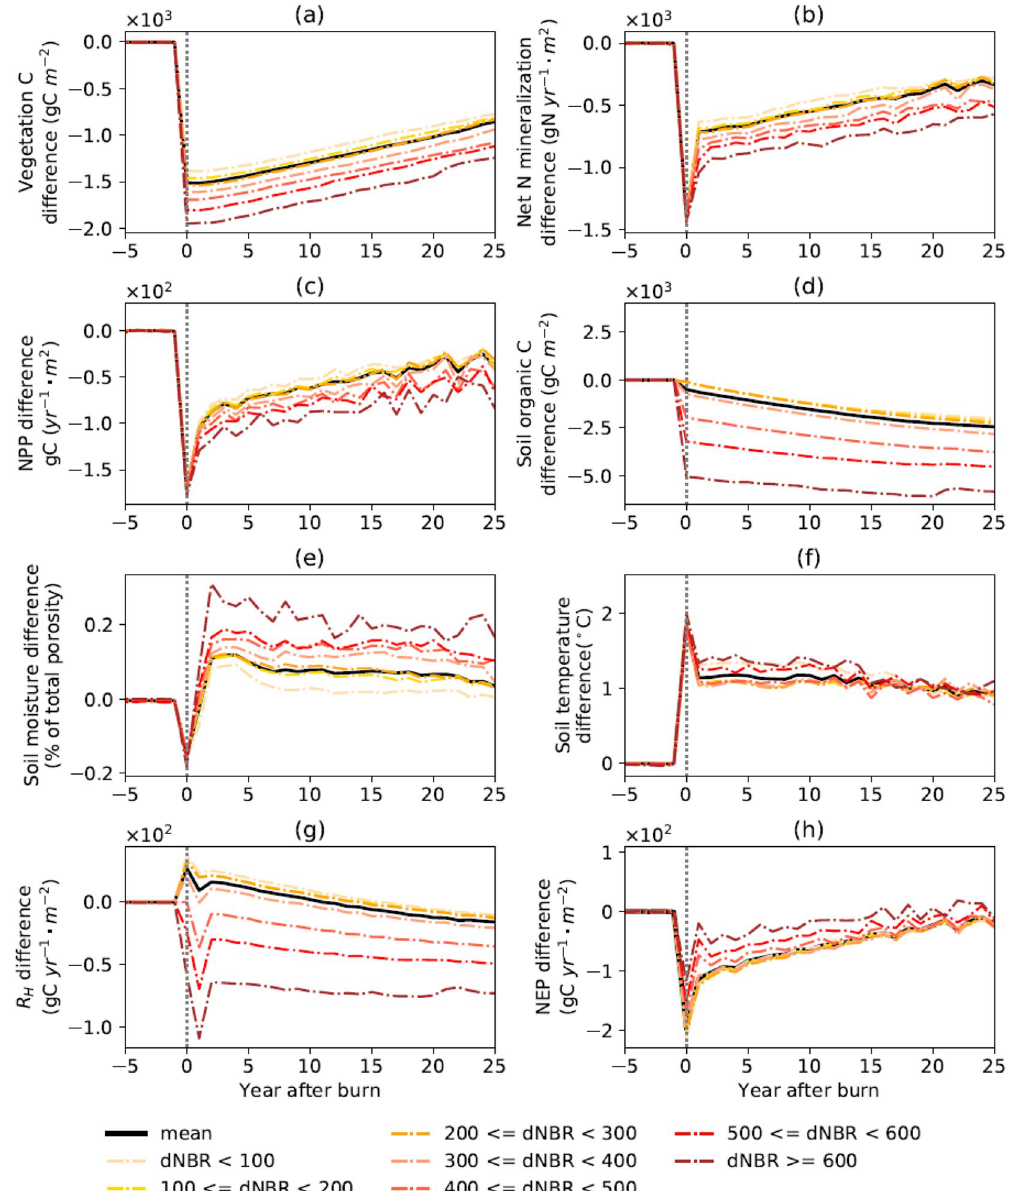
Figure 4. Difference of the changes in carbon pools and fluxes between the fire and the no-fire scenarios (the no-fire minus the fire scenario) under different levels of burn severity. Only cohorts burned once (95.2% of the total burned area) are used for calculation. The value of each curve is the average of all cohorts with corresponding dNBR values: ( a ) vegetation C (gC m −2 ); ( b ) annual net N mineralization (gN year −1 m −2 ); ( c ) annual NPP (gC year −1 m −2 ); ( d ) soil organic C (gC m −2 ); ( e ) soil moisture (% of total porosity); ( f ) soil temperature (°C); ( g ) Rh (gC year −1 m −2 ); (h) NEP (gC year −1 m −2